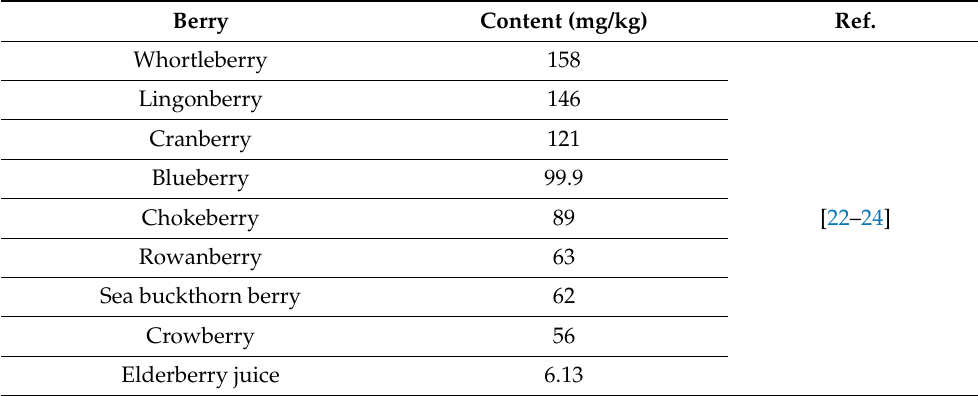
Table 1. The names of berries and their quercetin